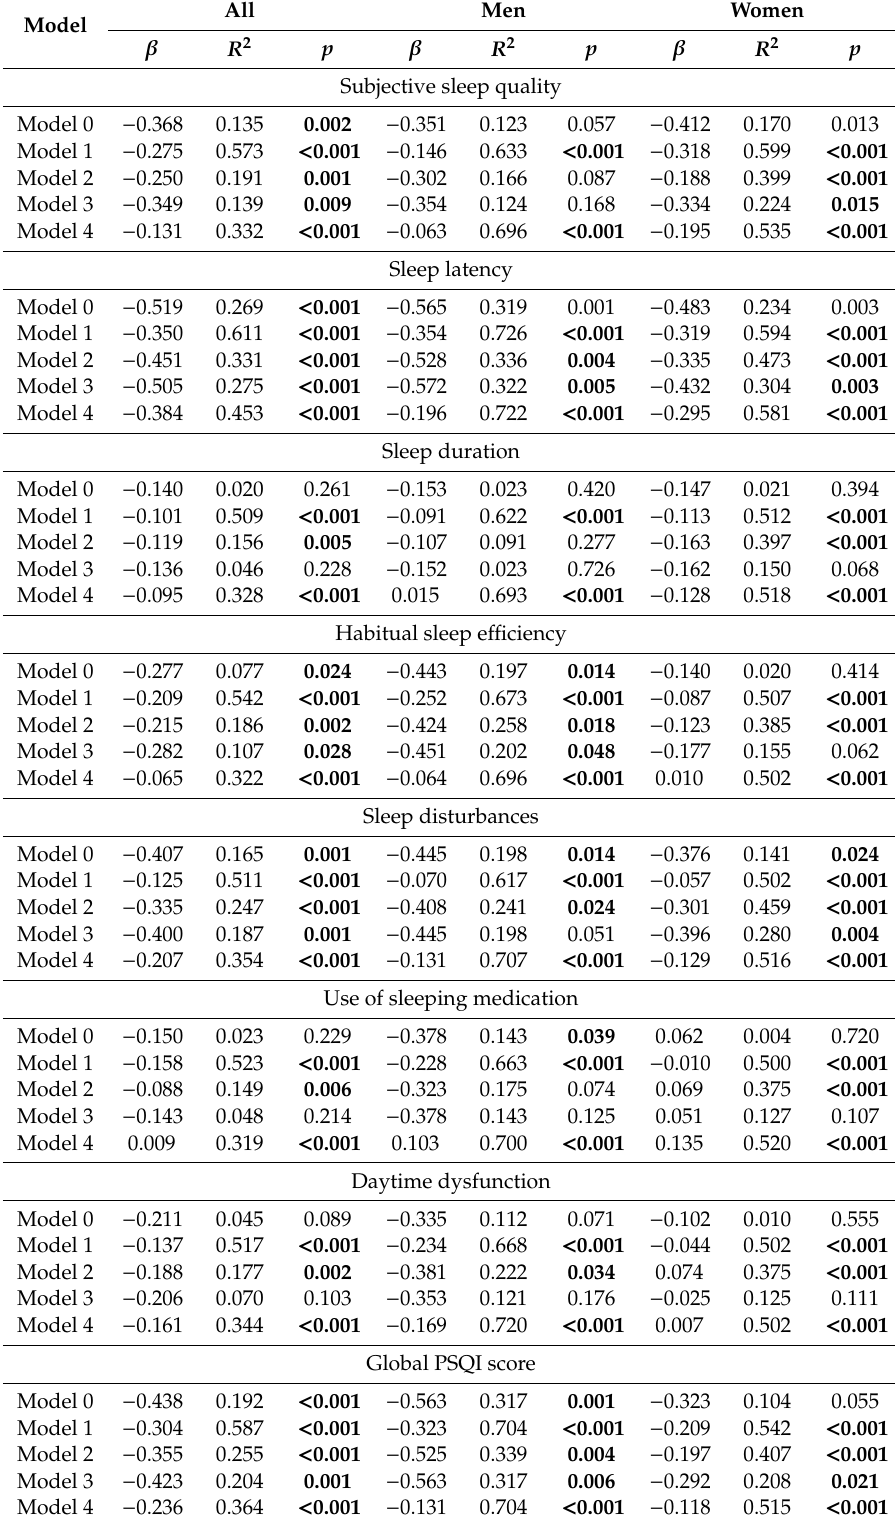
Table 3. Association of subjective sleep quantity and quality (components and global PSQI score) with the secreted Klotho plasma levels (Model 0) adjusted by age (Model 1), total fat mass percentage (Model 2), fat mass index (Model 3), and lean mass index (Model